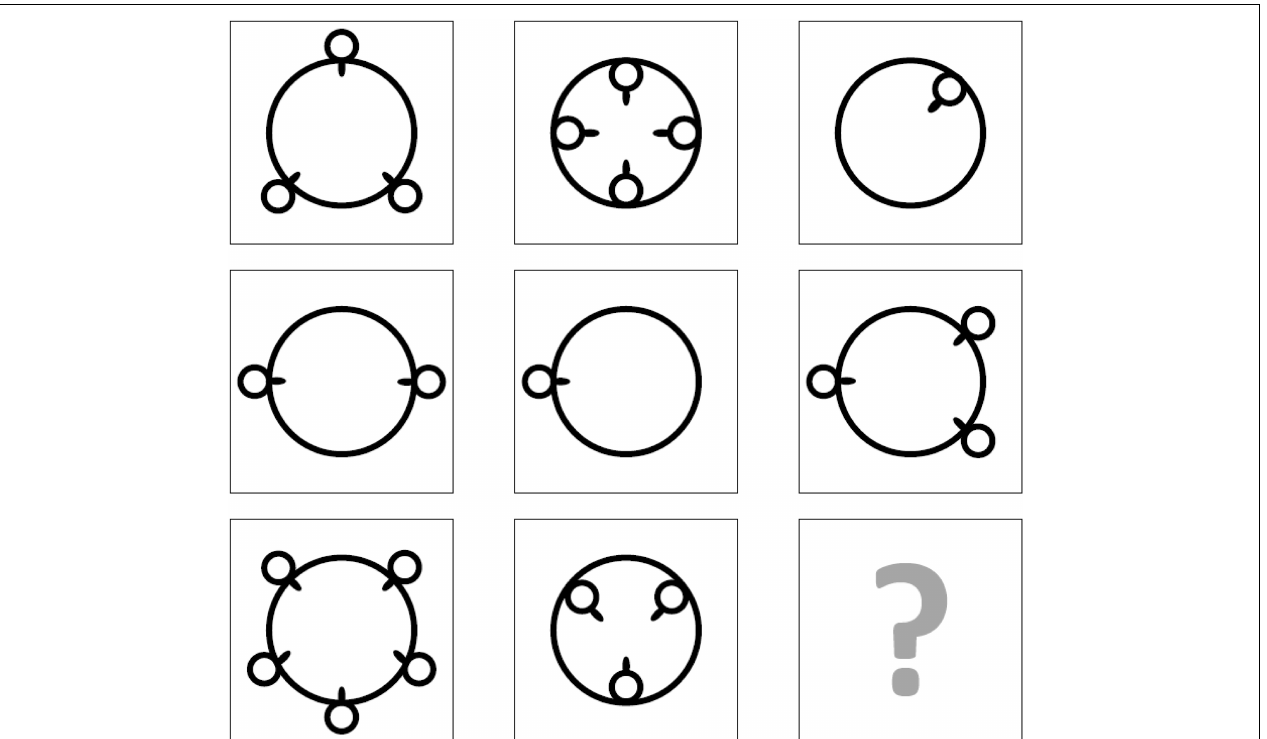
FIGURE 1 | Sample matrix adapted from Raven’s Advanced Progressive